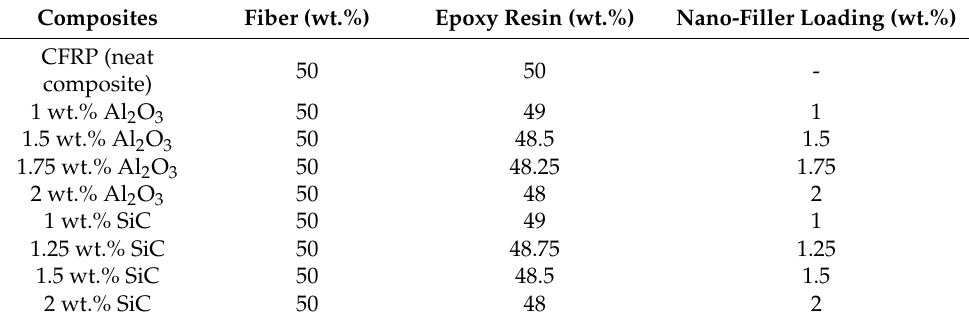
Table 2. Composites fabricated at different weight